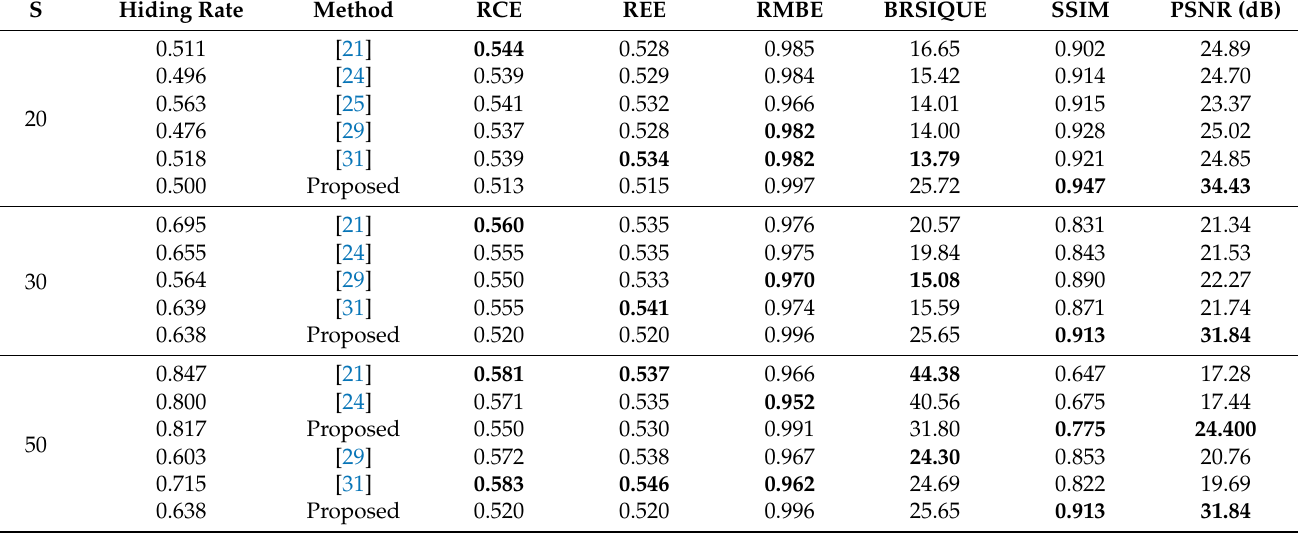
Table 5. Average metrics with Kodak dataset using F , C = 8 for BS